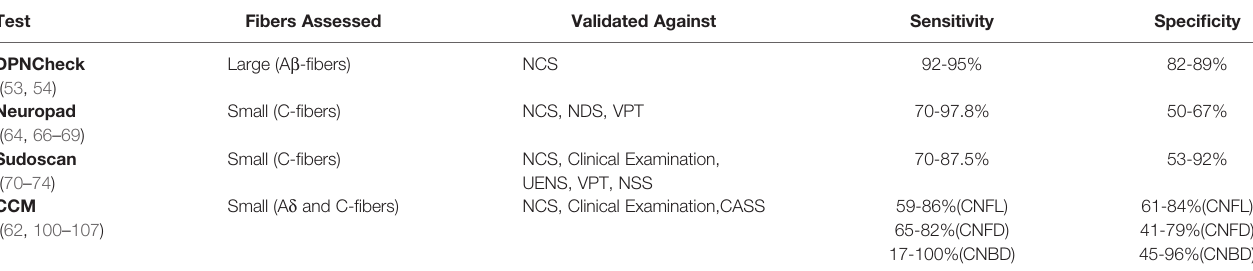
TABLE 4 | Summary studies for validity for four potential screening tests for